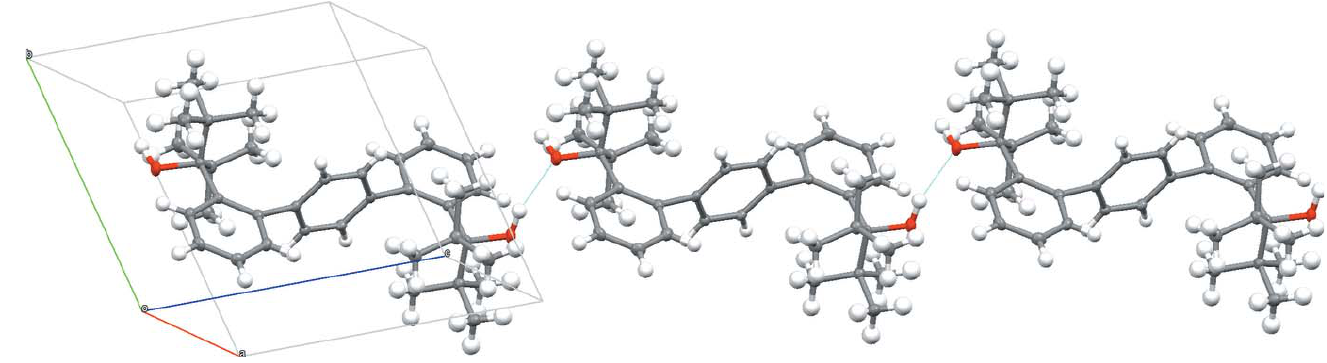
Figure 4 Chain of H 2 [OO] tBu molecules, bridged by hydrogen bonds (indicated in light blue).